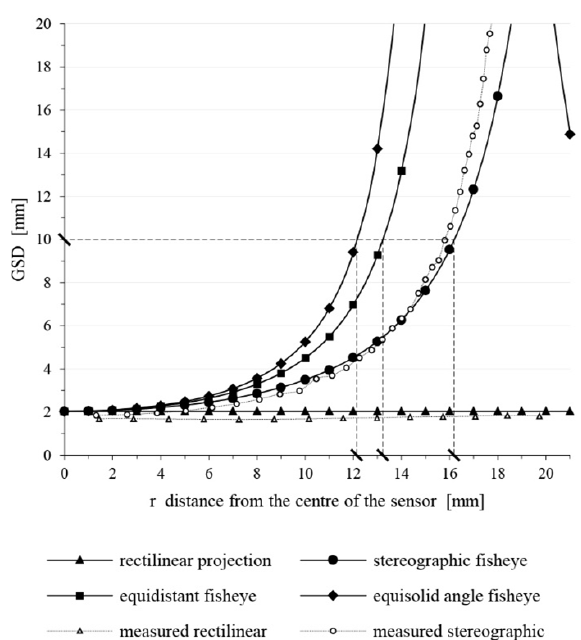
Figure 4. Comparision graph among different optical projection behaviour. The simulation is done for a camera with a pixel size of cir ca 4,9 Microns, a focal length of 12mm and a taking distance from the object of 2,5 m.